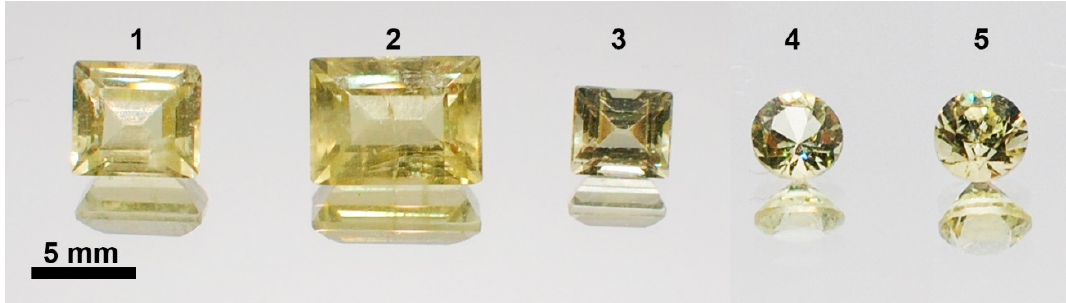
Figure 4. Apatite from Muránska Dlhá Lúka cut as gemstones—samples 1–5 according to Table 1. Photo by J. Štub ň a.